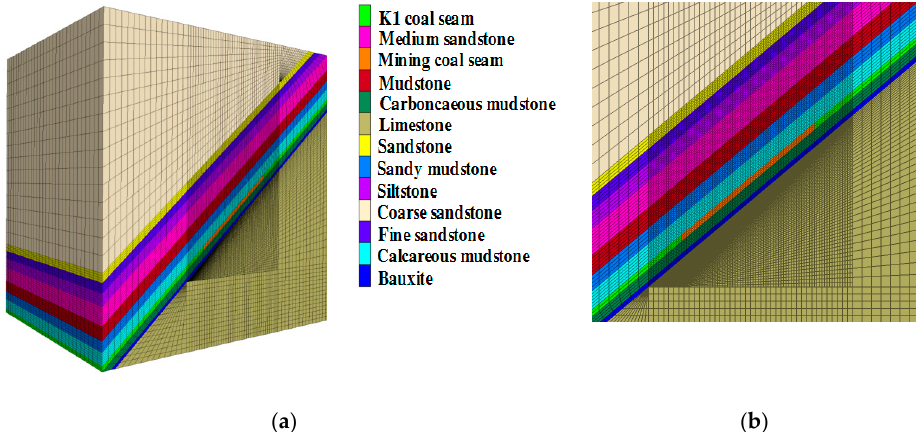
Figure 2. The numerical simulation benchmark model. Blocks of different colors represent different layers as shown in the legend of ( a ). ( a ) 3D drawing of model; ( b ) Front view of the model. The mining height of the coal seam was 3.2 m, the length of the working face was 105 m, and the inclination angle was 40°. The whole model consisted of 936,870 elements, including 965,705 nodes. The simulated filling ratios were no filling, 1/5, 1/3, 1/2, and 2/3, respectively.